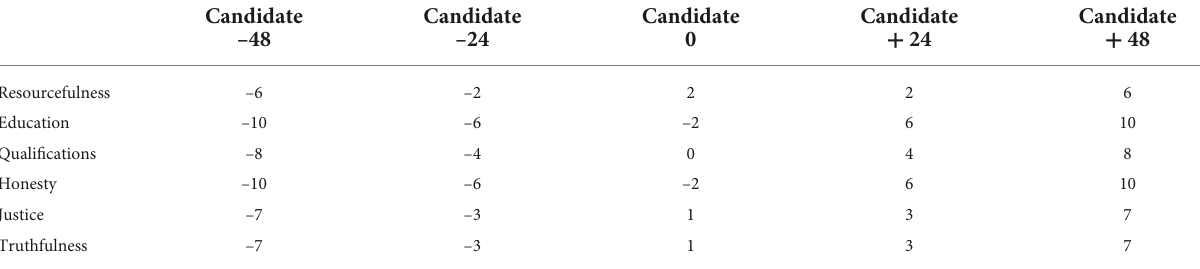
TABLE 1 Candidate profiles used in study